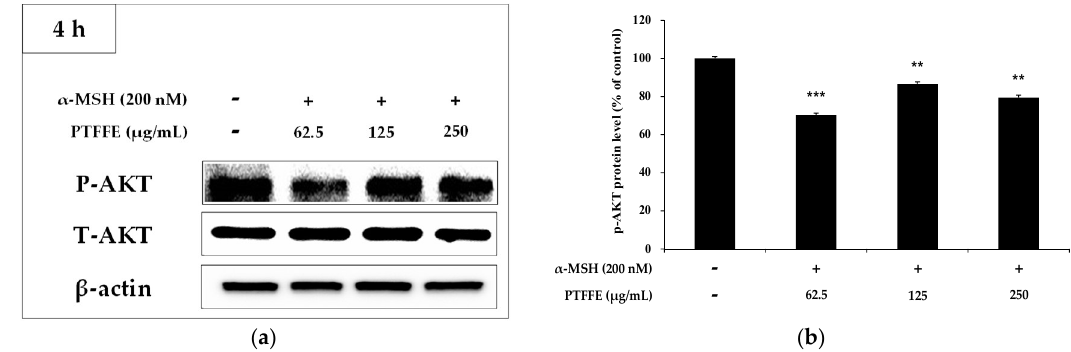
Figure 5. Effects of PTFFE on AKT phosphorylation. B16F10 cells were treated with the indicated concentrations of PTFFE for 4 h. ( a ) Protein expression levels were investigated by western blotting. ( b ) Results are expressed as percentages of the untreated cells. The data are presented as the mean ± SD of at least three independent experiments. ** p < 0.01, *** p < 0.001. P: phosphorylated, T: total.